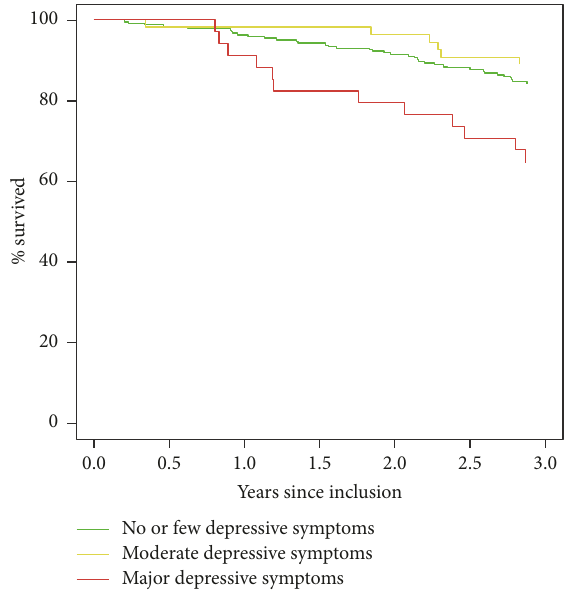
Figure 1: Depressive symptoms and death.